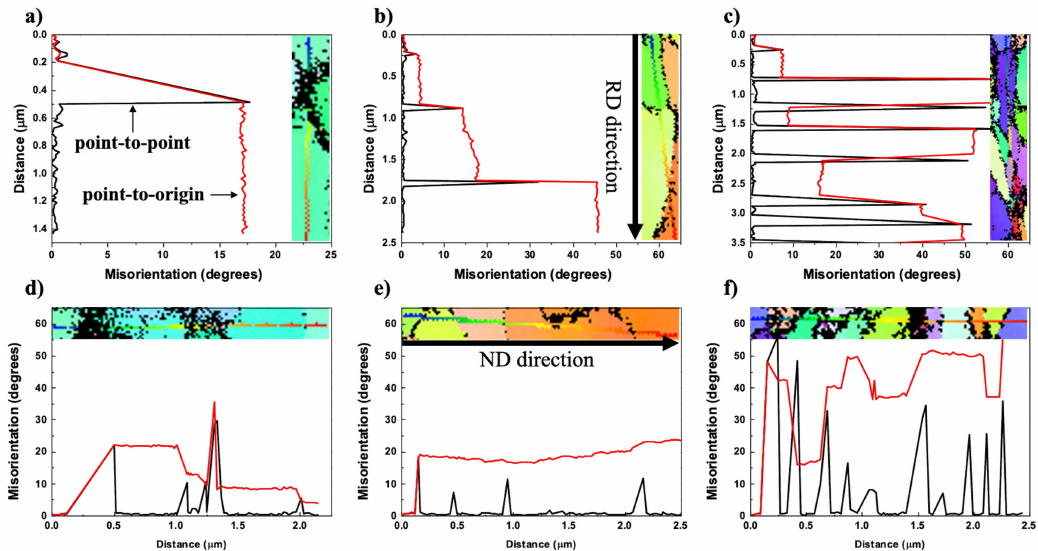
Figure 6. Misorientation angle profiles of ( a , d ) AM2, ( b , e ) AM5, and ( c , f ) AM9 across the rotated zone formed around α -Al(Mn, Fe)Si precipitate. The point-to-point line (black) indicates the profile of the orientation changes between adjacent point. The point-to-origin line (red) represents the profile of the orientation changes between all points and origin